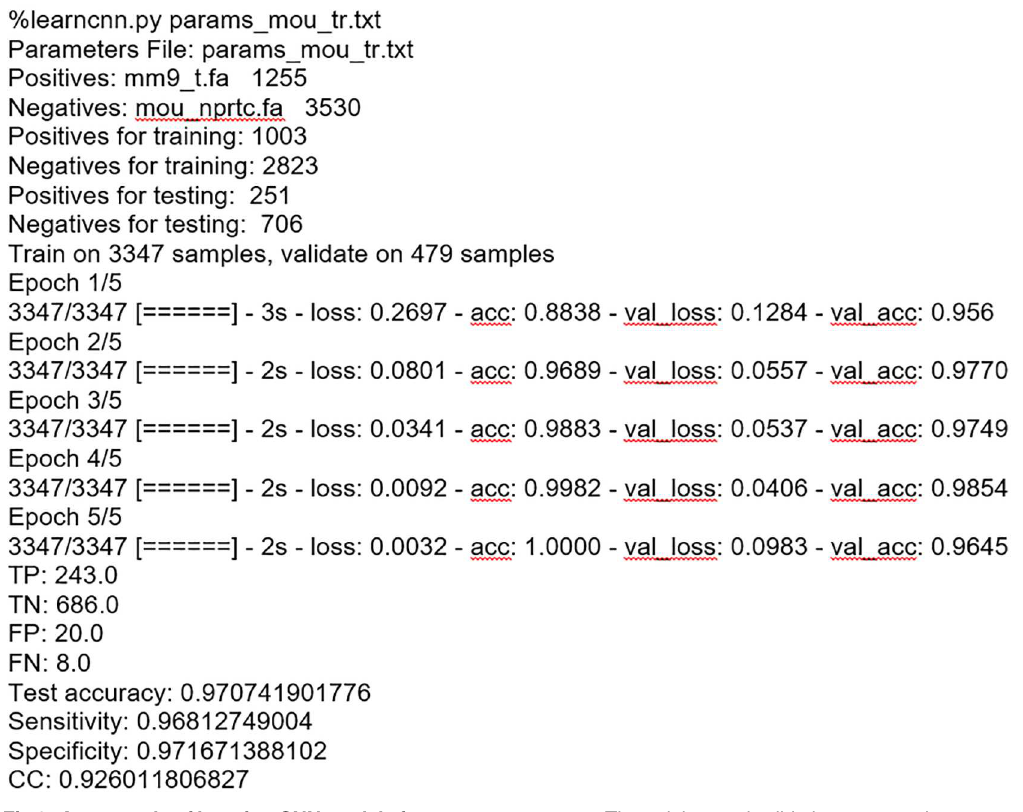
Fig 2. An example of learning CNN models for mouse promoters. The training, and validation accuracy is presentedfor each learningepoch. Finally, the performance on the test data is